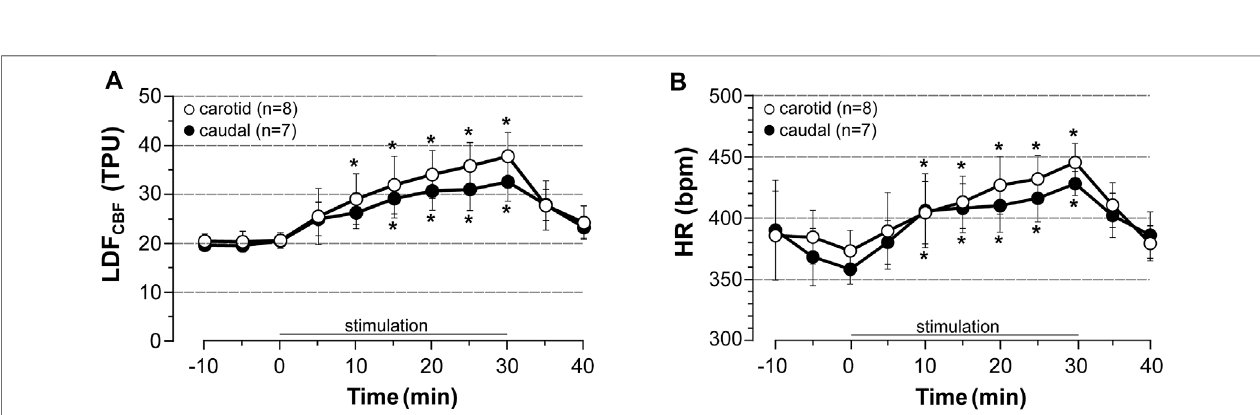
FIGURE 2 | Effects of induced contraction on LDF CBF in the area representing the hindlimb LDF CBF in the cortical area representing the hindlimb and HR were measured before, during (0 – 30 min) and after electrically induced contraction of hindlimbs (5x MT). HR was calculated from a BP trace that was recorded from the common carotid artery (carotid series) or the caudal artery (caudal series) in rats anesthetized with chloral hydrate. Values are expressed as means ± SD, n = number of rats.*signi fi cantlydifferentfrompre-stimulationvaluesat p < 0.01andnodifferencebetweenseriesaftertwo-way(timexgroup)ANOVAandBonferronicorrection.